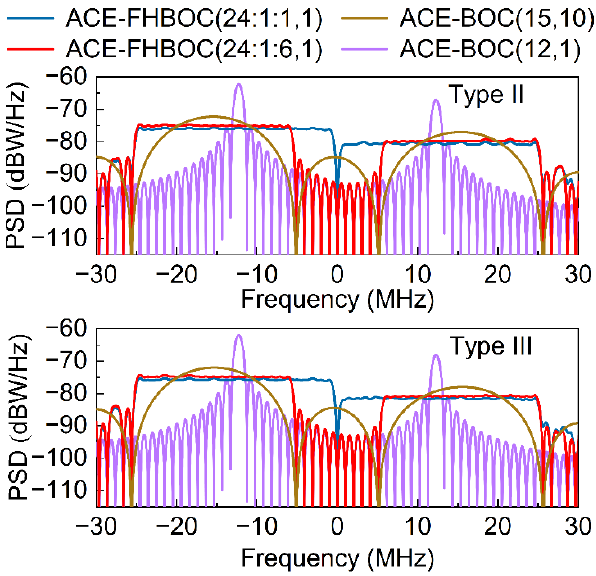
Figure 10. PSDs of the Type-II and Type-III example signals.